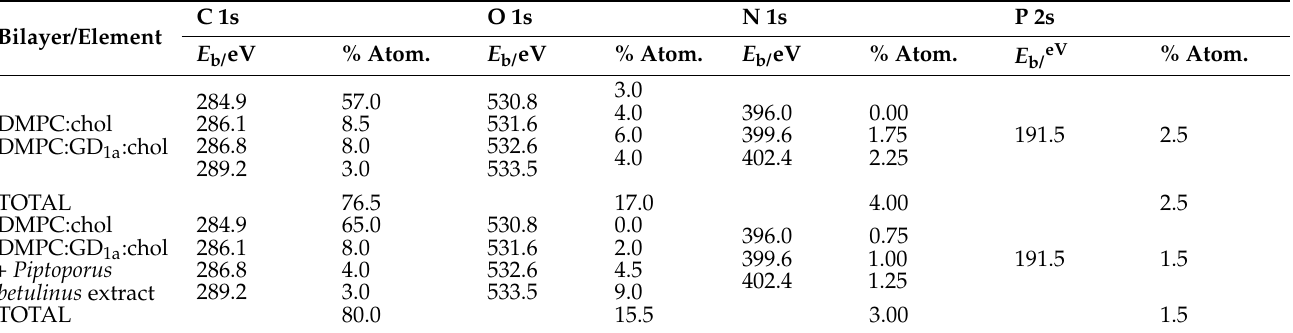
Table 2. Element composition of the pure DMPC:chol—DMPC:GD 1a :chol bilayer and after its interaction with the Piptoporus betulinus